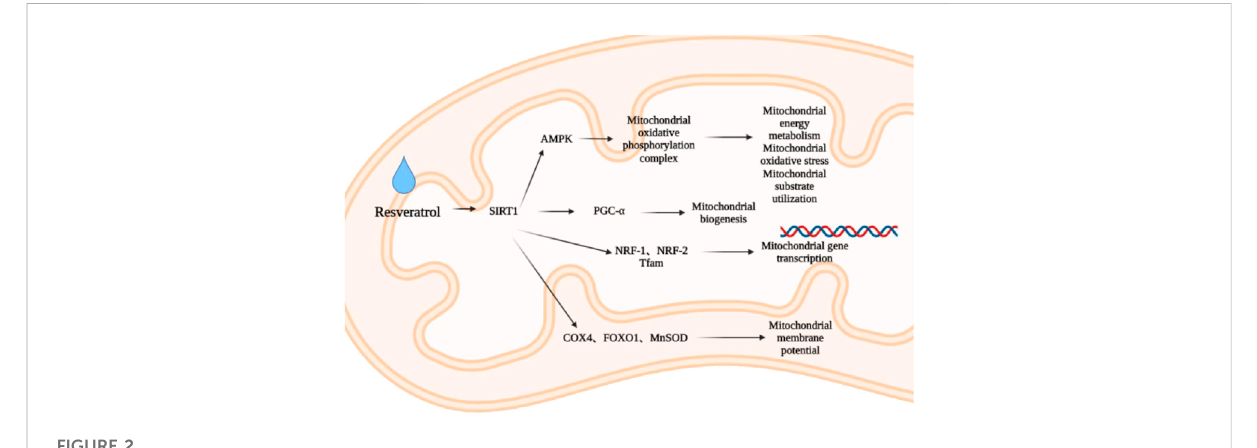
FIGURE 2 Effect of resveratrol on mitochondrial